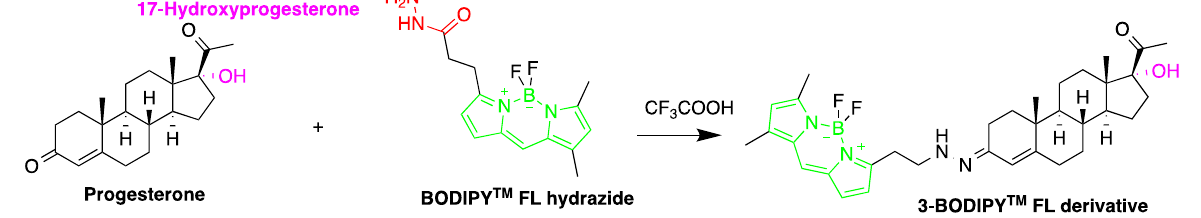
Figure 12. Derivatization of progesterone by 4,4-difluoro-5,7-dimethyl-4-bora-3a,4adiaza-s-indacene-3-propionohydrazide (BOD-IPYTM FL hydrazide).